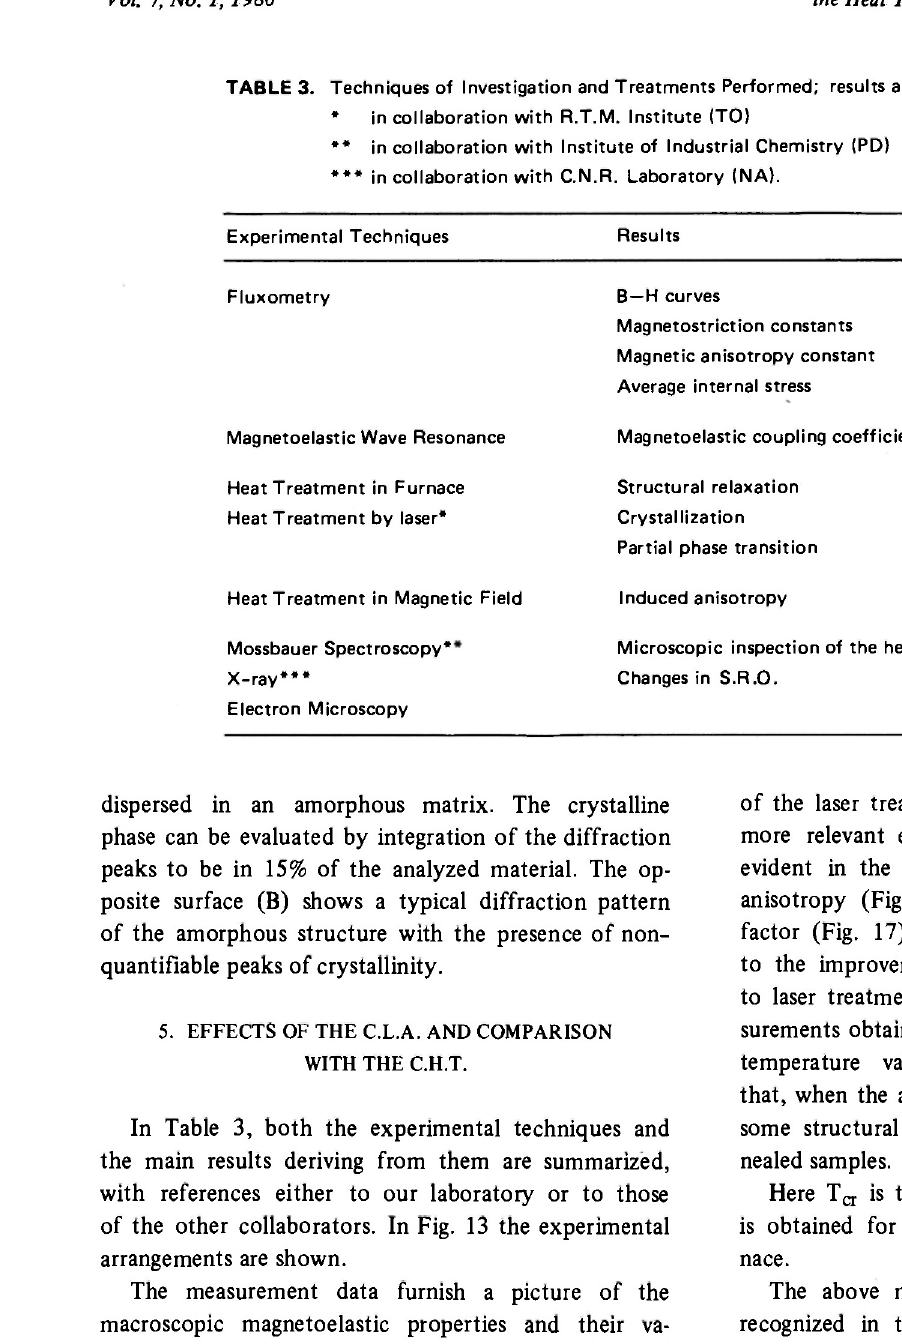
TABLE 3. Techniques of Investigation and Treatments Performed; results and effects, which can be